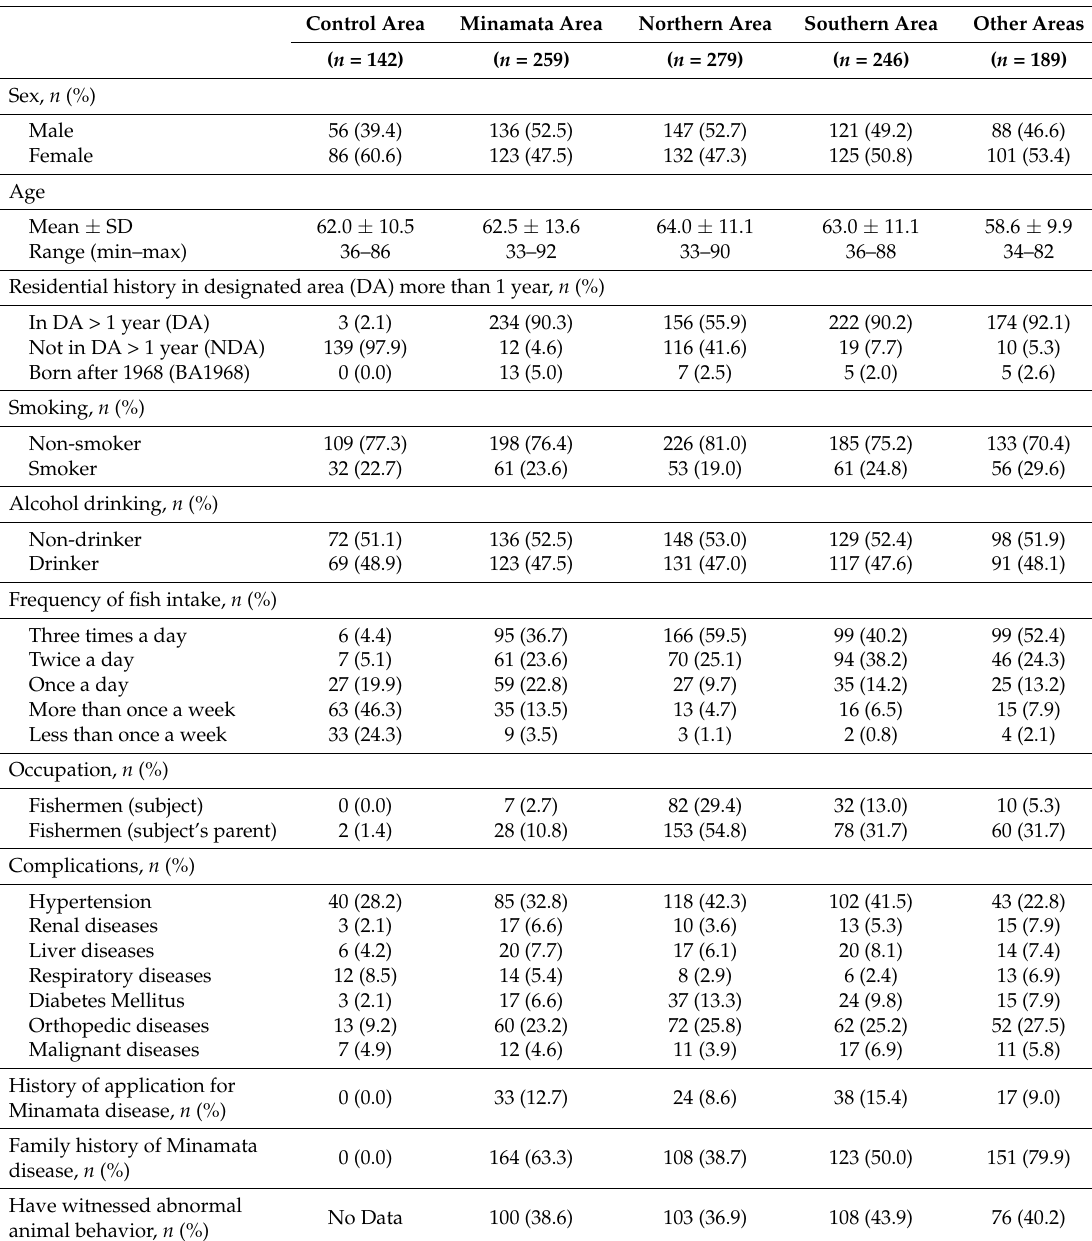
Table 2. Demographic characteristics of subjects in each area ( n =